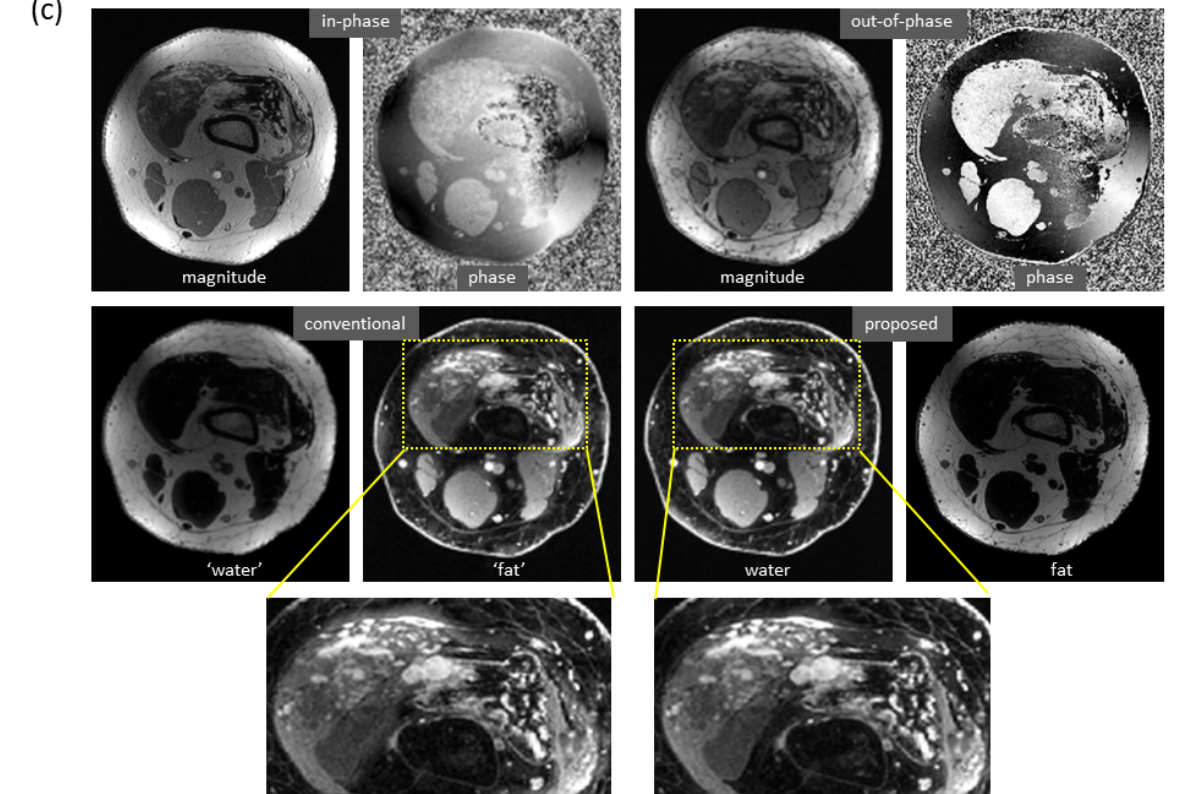
Figure 5. Marked correction of severe water/fat swaps. ( a ) In an examination of the ankle, progres- sively severe water/fat swaps occurred in the reference images as they moved farther from isocenter (every ninth slice is shown). In the predicted images, the water/fat swaps were completely corrected. ( b ) In an examination of the foot, severe water/fat swaps appeared in the peripheral region of the reference images, where the dashed arrow showed an accessory ossicle with marrow edema that also had a local swap in its marrow. The water/fat swaps were substantially compensated in the predicted images, which only had smaller regions of swaps (solid arrows). ( c ) Global water/fat swaps, which occurred in the reference image, were corrected using the proposed deep learning method. An improved spatial resolution was observed in the predicted image.